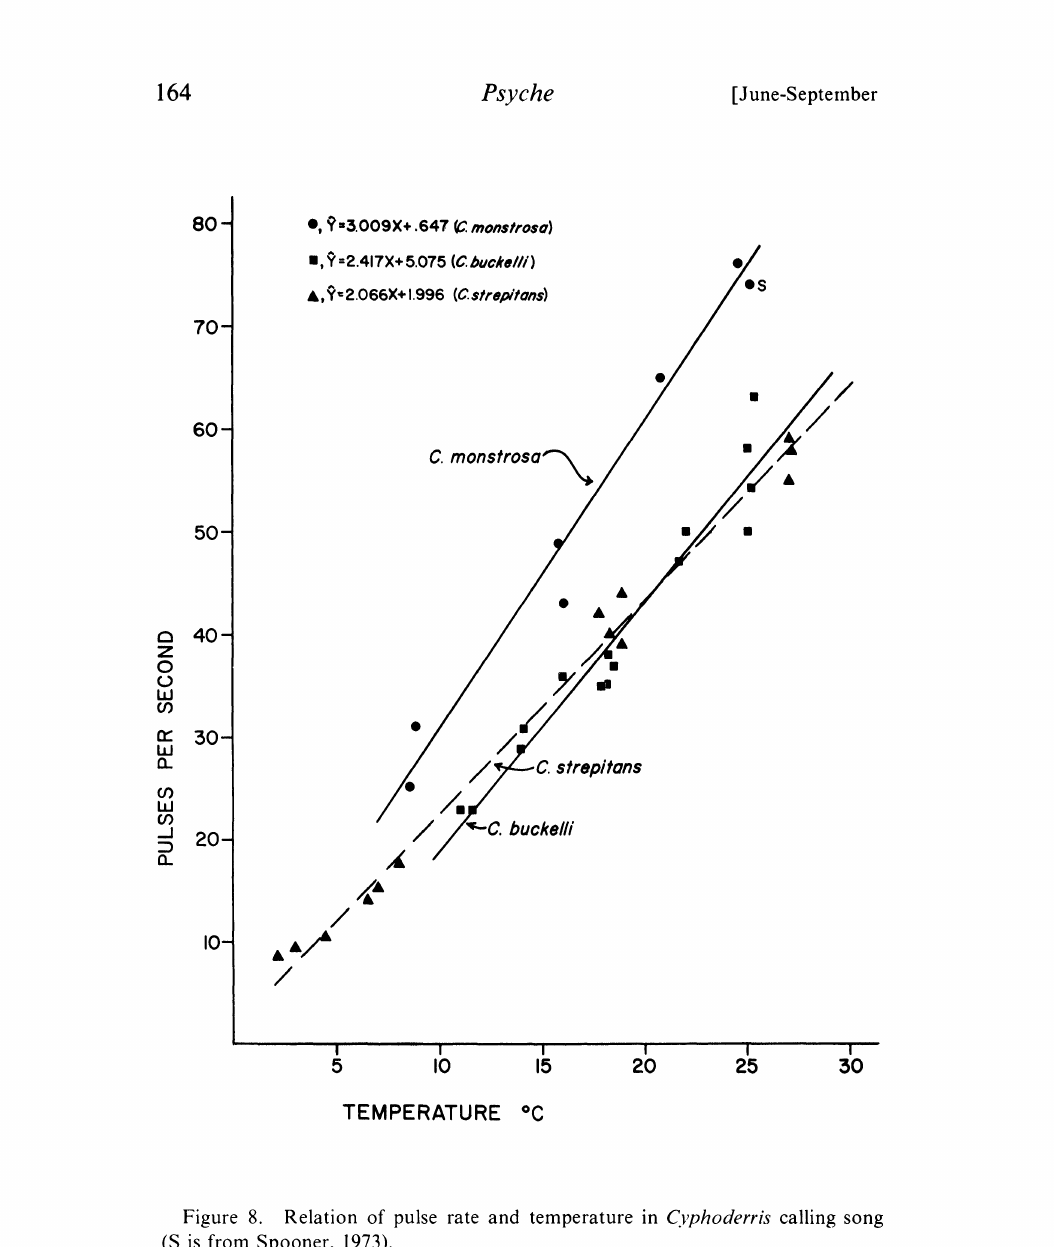
Figure 8. Relation of pulse rate and temperature in Cyphoderris calling song (S is from Spooner,